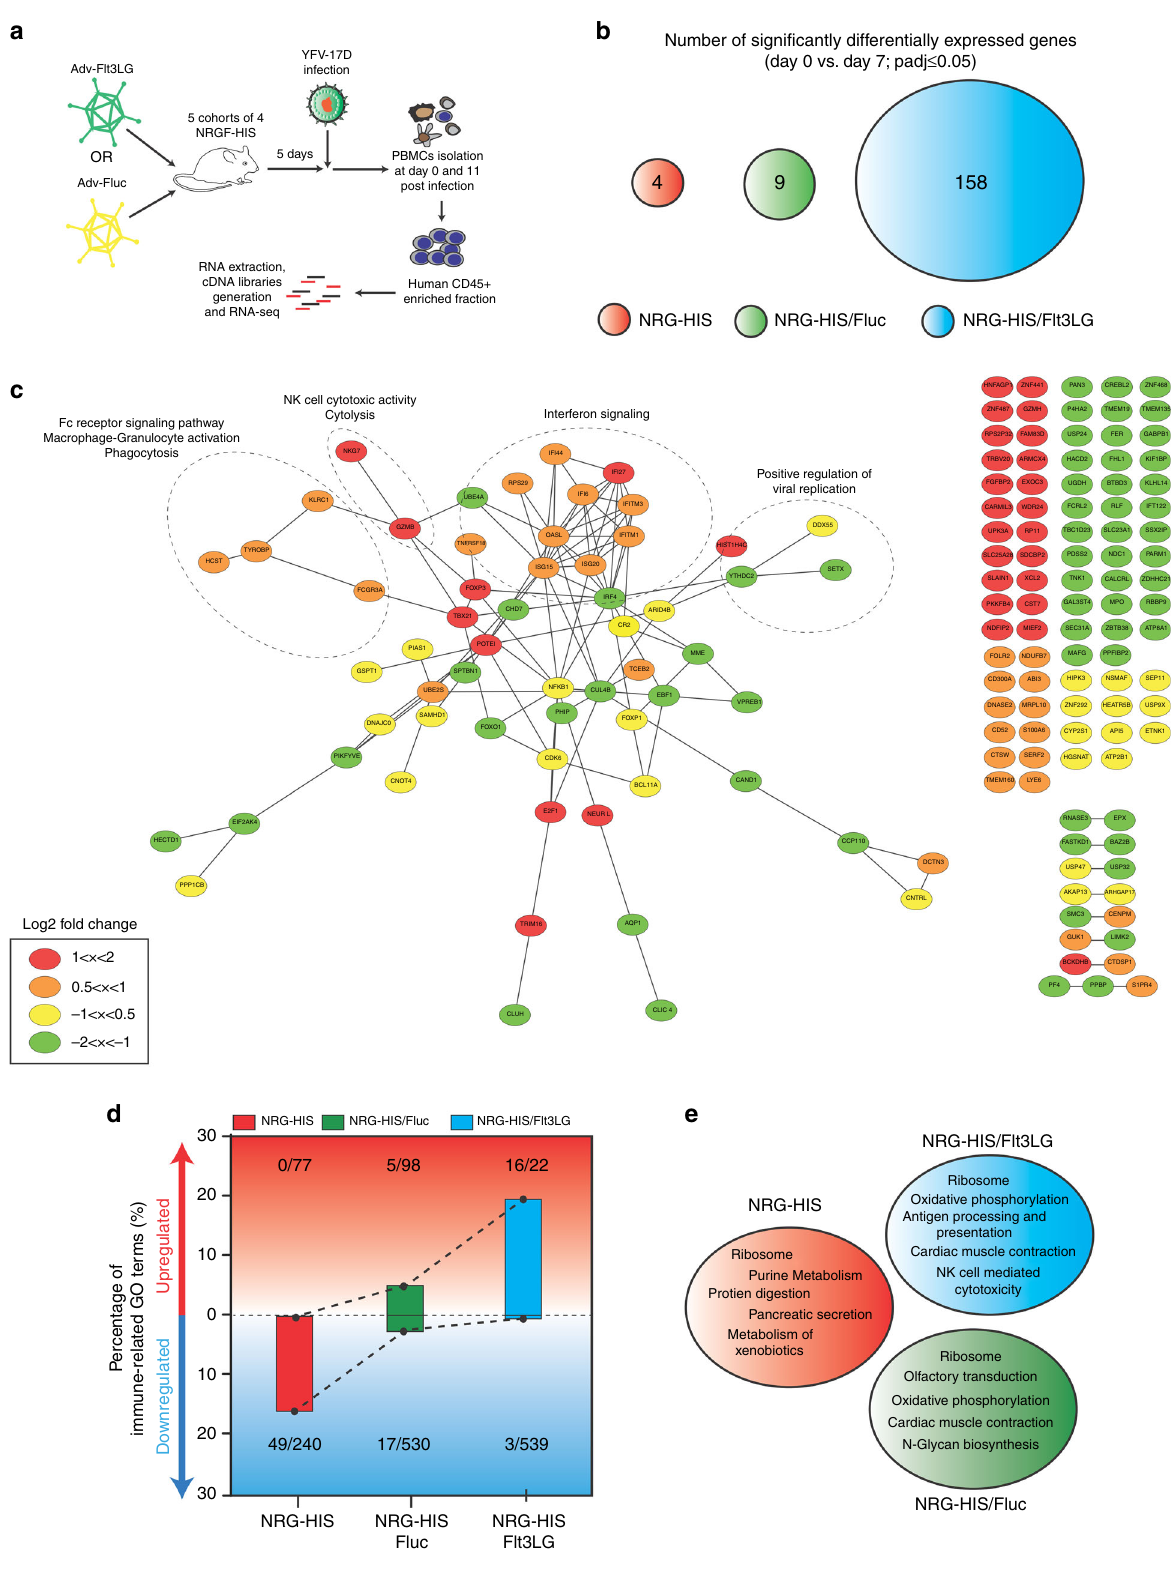
Transcriptomic signatures to YF-17D in NRGF-HIS/Flt3LG mice . By RNA-seq, NRGF-HIS/Flt3LG mice exhibited a signature of 158 genes signi fi cantly DE ( p ≤ 0.05) while NRG-HIS and NRGF-HIS/Fluc mice displayed, respectively, 4 and 9 DE genes (Figs. 2d and 4a, b; Supplementary Figure 4a, b; Supplementary